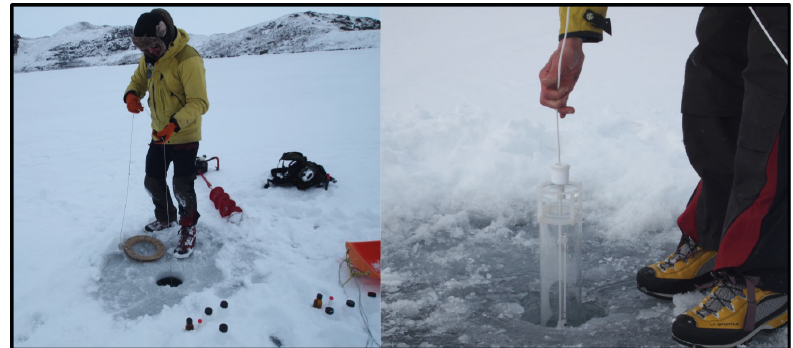
Figure 6. Lake water sampling on the lake ice using a Ruttner